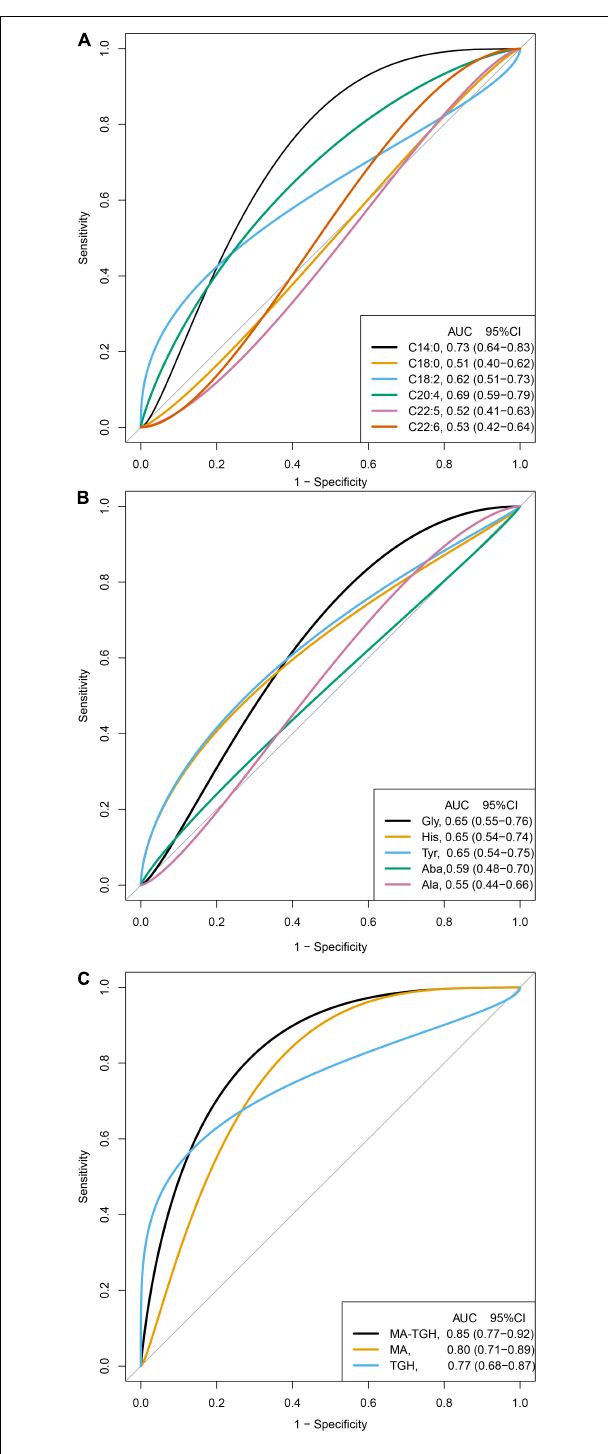
FIGURE 2 | Discrimination ability of the fatty acids, amino acids, and the indicator for identifying participants in the intervention group of RCT 2 ( N = 110). MA, the ratio of myristic acid (C14:0) to arachidonic acid (20:4); TGH, the ration of tyrosine to the sum of glycine and histidine; MA-TGH, multiplying MA by TGH calculated by C14:0 × tyrosine × 1,000/[C20:4 × (glycine + histidine)]. (A) Discrimination ability of the fatty acids in the RCT2. (B) Discrimination ability of the amino acids in the RCT2. (C) Discrimination ability of combined indicators in the